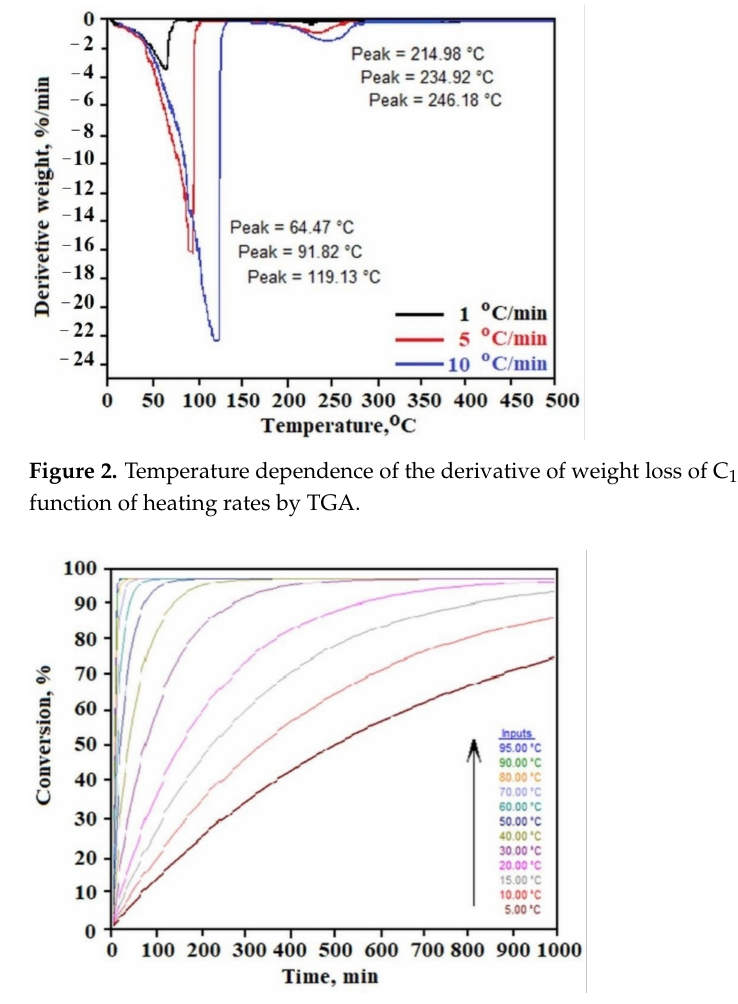
Figure 3. Time dependence of sample conversion as a function of temperature obtained by OFW